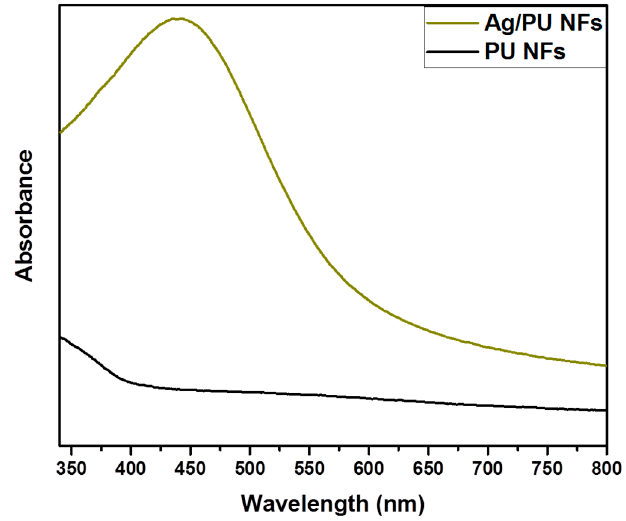
/ PU NFs and PU Figure 5. UV–Vis spectra of the Ag/PU NFs and PU NFs. Figure 5. UV–Vis spectra of the Ag Figure 5. UV–Vis spectra of the Ag/PU NFs and PU NFs.